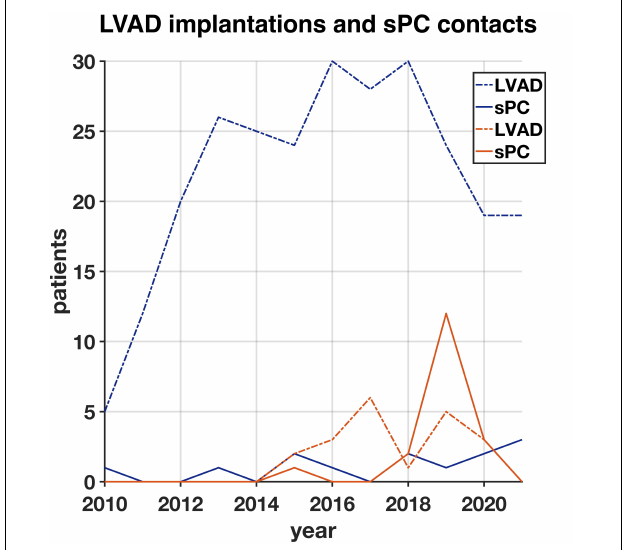
FIGURE 1 | Number of all patients (with research agreement) who had a left ventricular assist device (LVAD) implanted from 2010 until 2021 in Duesseldorf (blue, n = 262) and Basel (orange, n = 20) and number of LVAD patients having their first specialist Palliative Care (sPC)-contact in each year in Duesseldorf (blue, n = 13) and Basel (orange, n =